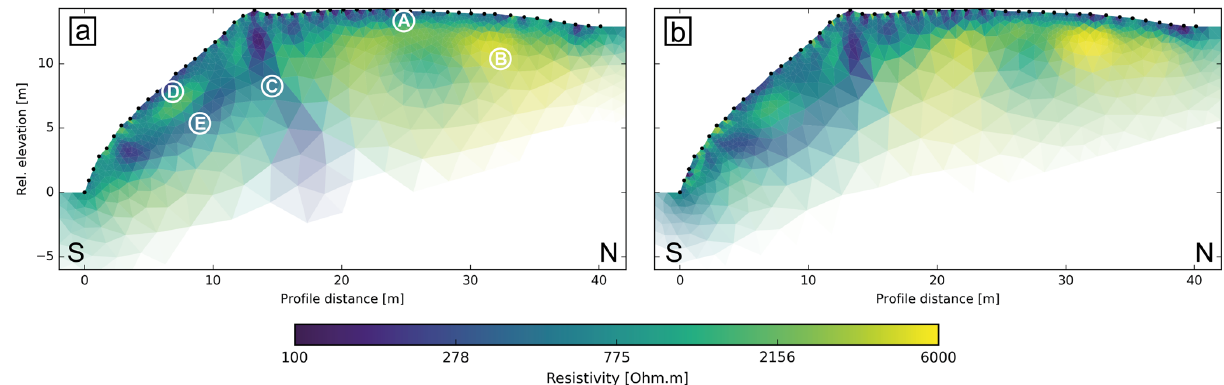
Figure 5. Image of the inverted resistivities for DD (a) and GD (b) data sets in average weather conditions (March 2017). Letters (A–D) indicate anomalies described in the main